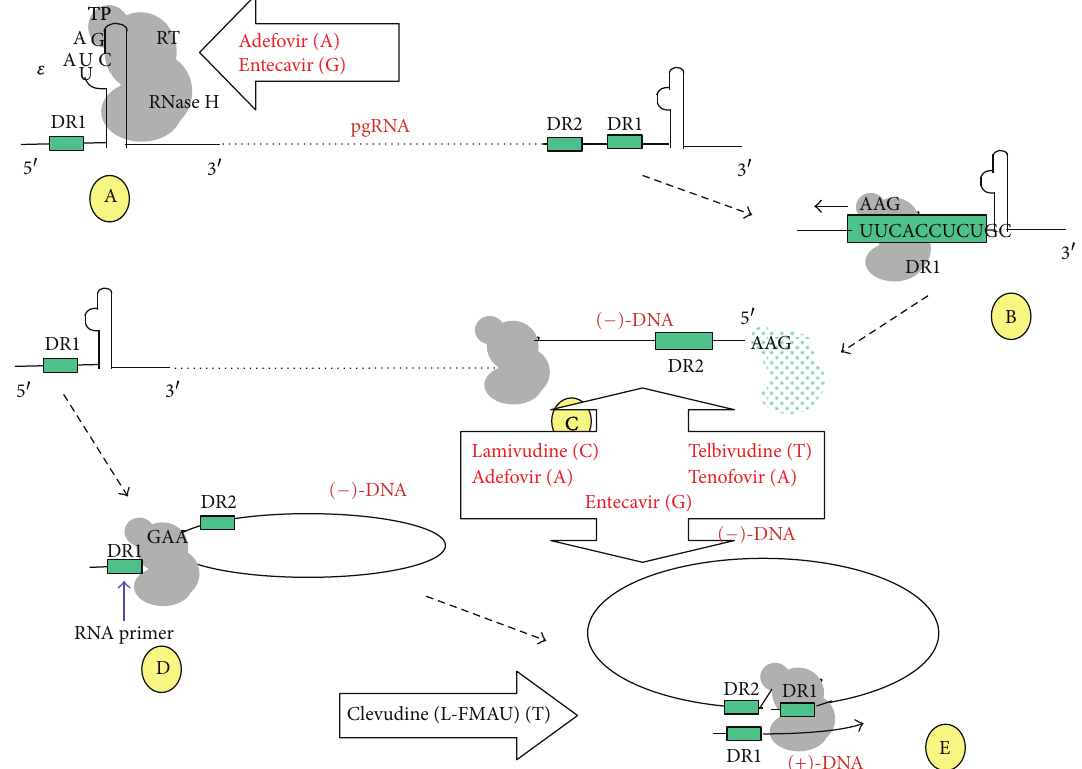
F 2: e replication strategy of hepatitis B virus and stages of: (A) binding of the viral polymerase to using as template the nucleotide sequence of the bulge as shown. (B) Translocation of the polymerase/primer complex to the